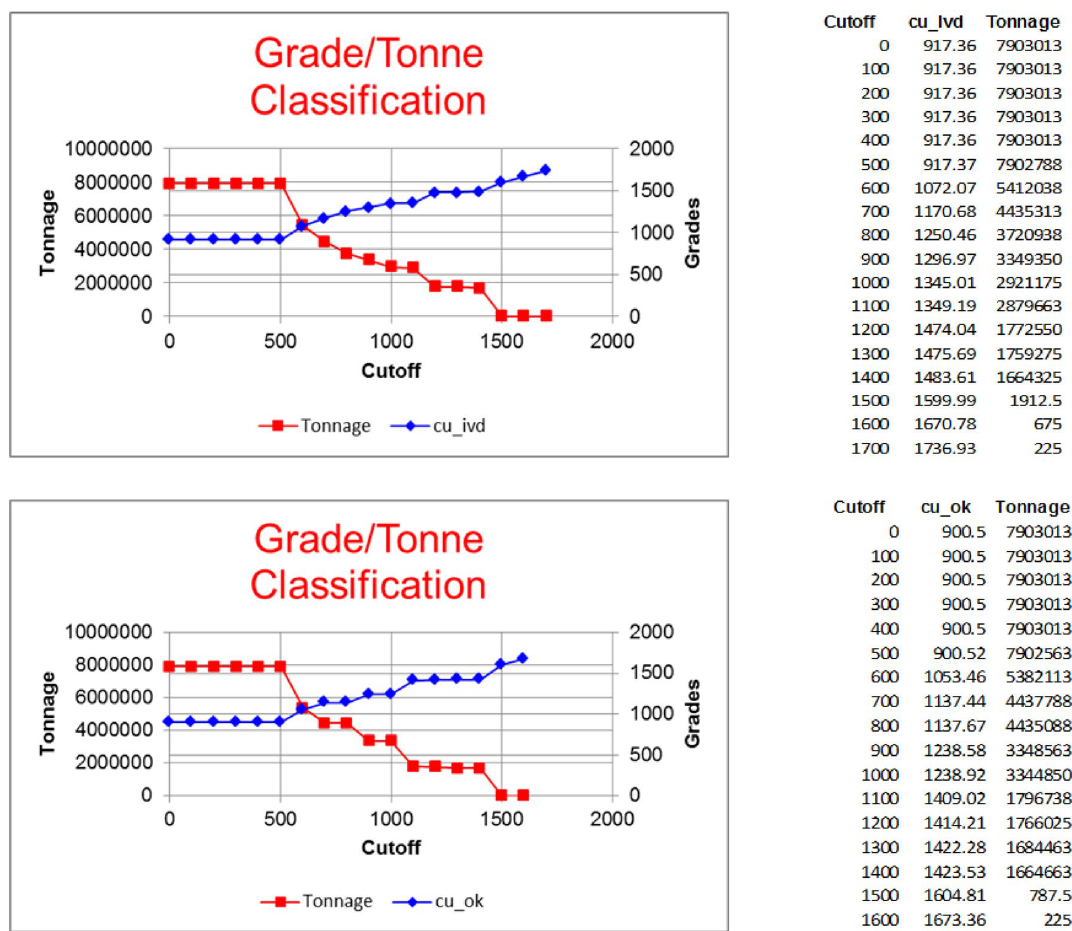
Fig. 5 Musina mine tailings dump grade/tonne report for Cu comparing OK (cu_ok) and IVD (cu_ivd)